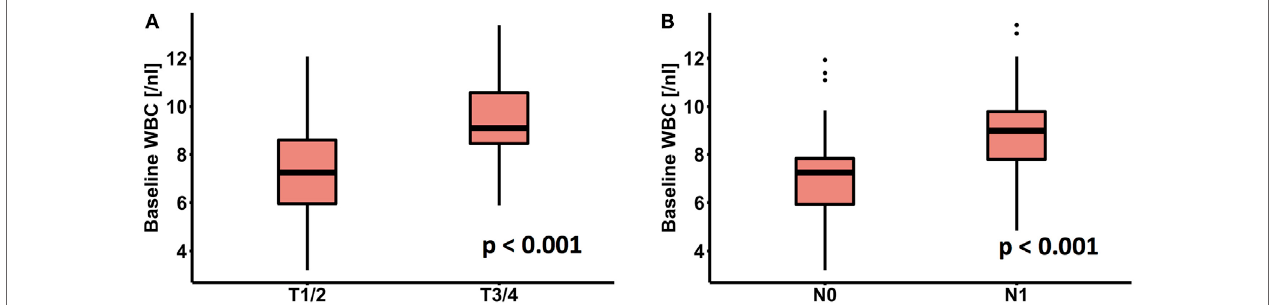
FigUre 1 | Association of peripheral white blood cell (WBC) with (a) T-stage and (b)